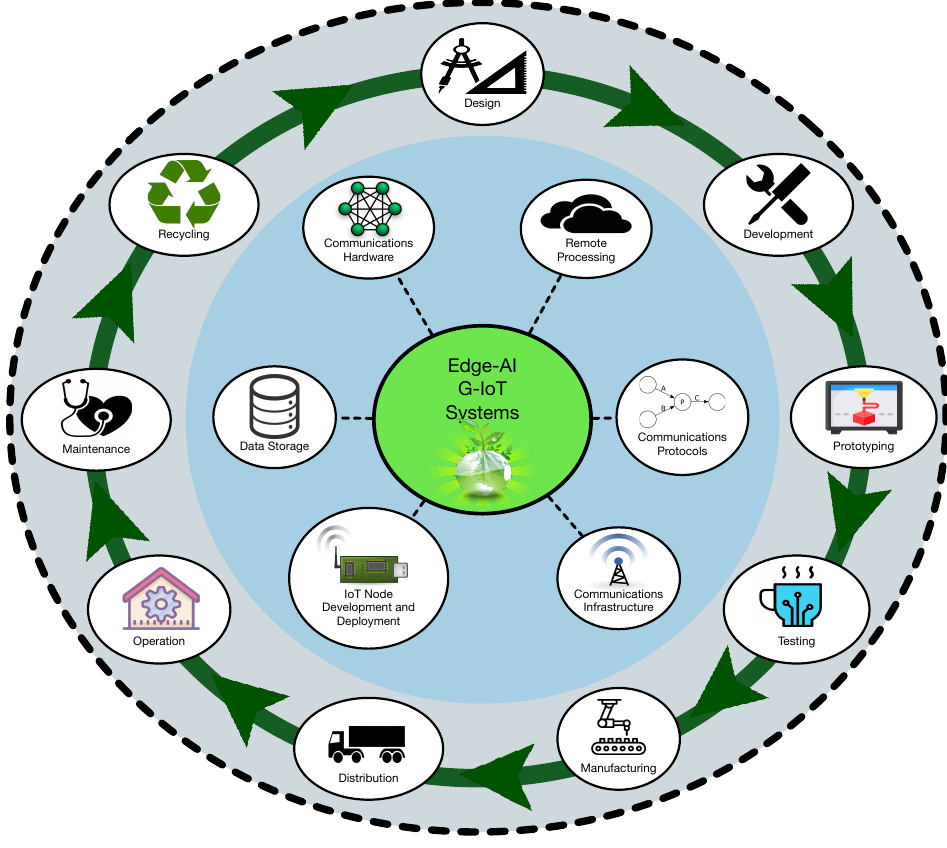
Figure 1. Edge-AI G-IoT main areas and their digital circular life